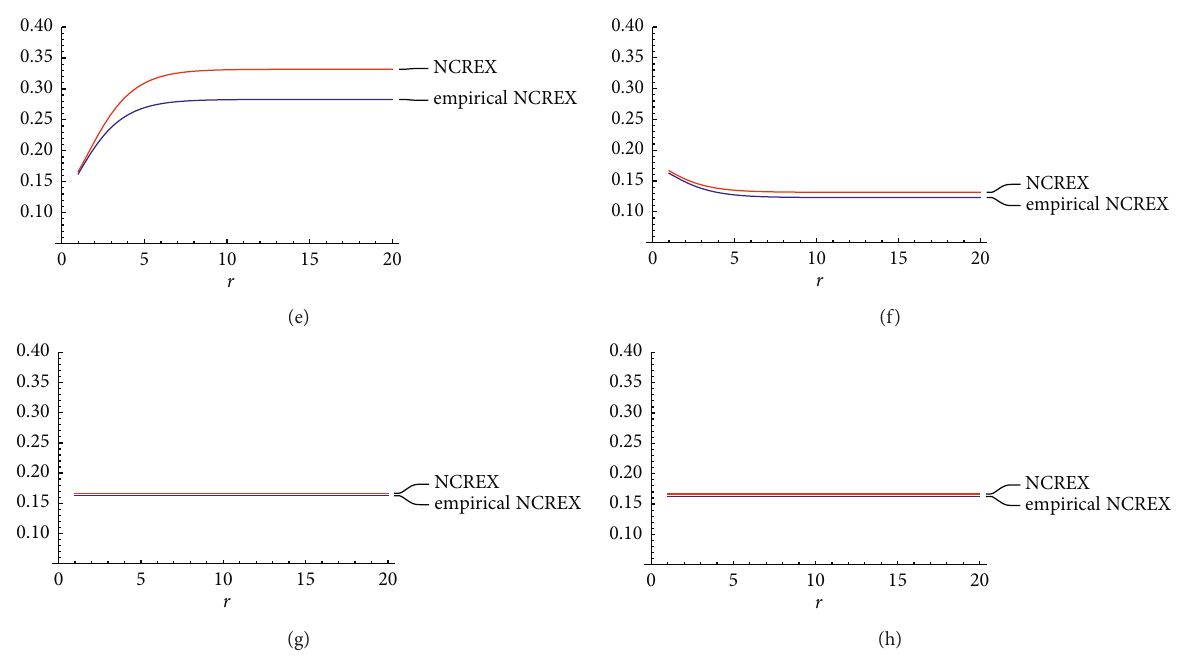
� 1, λ � − 1. (b) p � 1, λ � 1. (c) p � 2, λ � [ r ] from HK-FGM-UD. (a) p